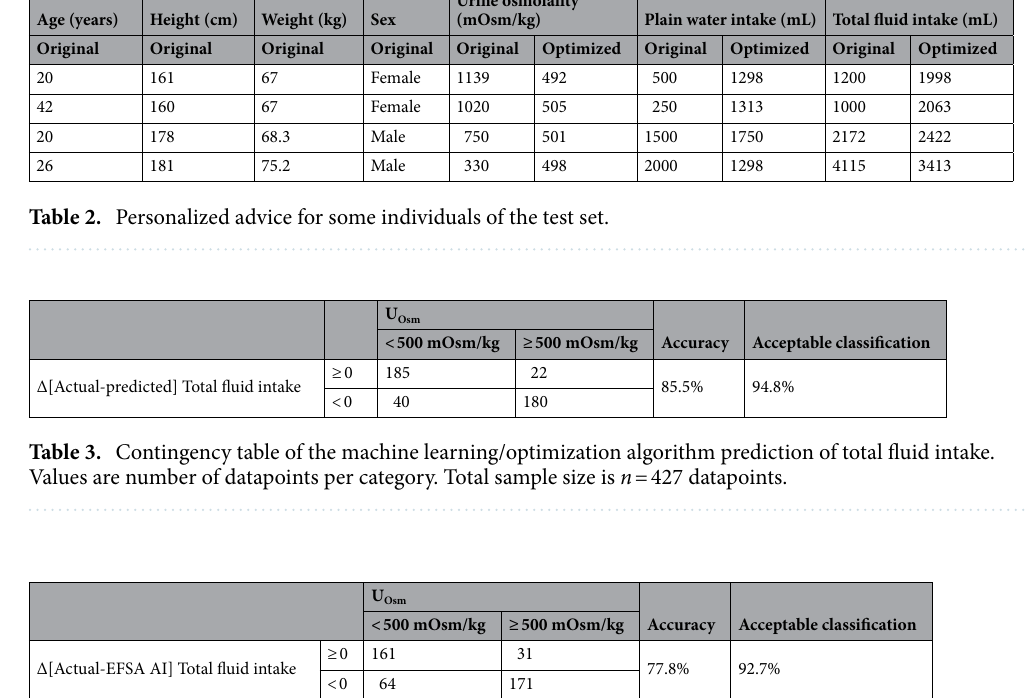
Table 4. Contingency table of values for total water intakes coming from fluids deriving from the European Food Safety Authority (EFSA) dietary guidelines. Values are number of datapoints per category. Total sample size is n = 427 datapoints. EFSA AI European Food Safety Authority Adequate